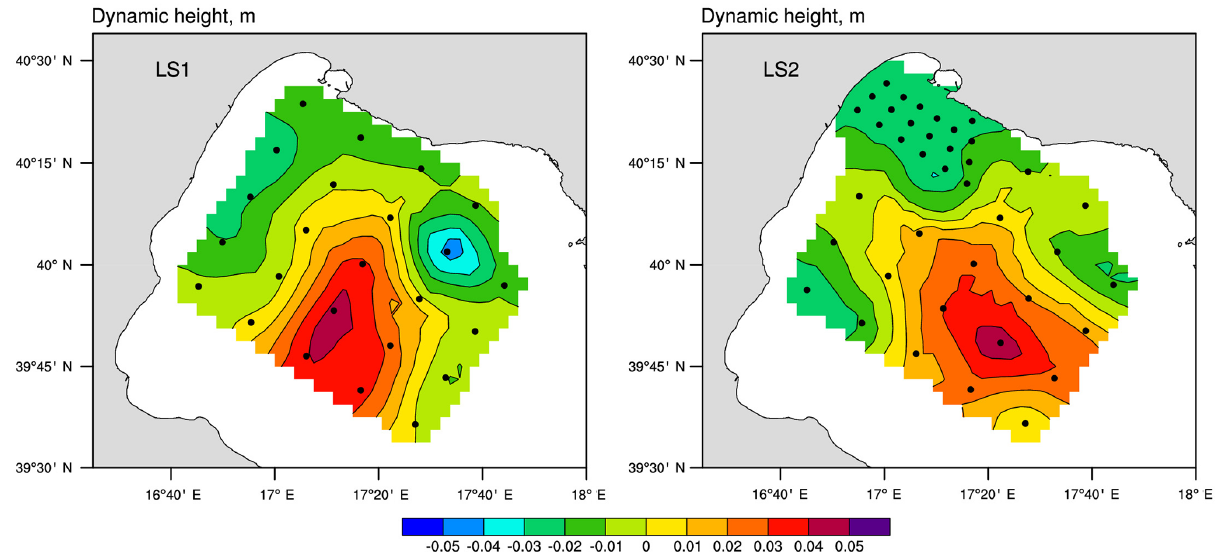
Figure 14. Dynamic height at 10m with respect to 100m reference level. Left panel: LS1. Right panel: LS2 + CS1.